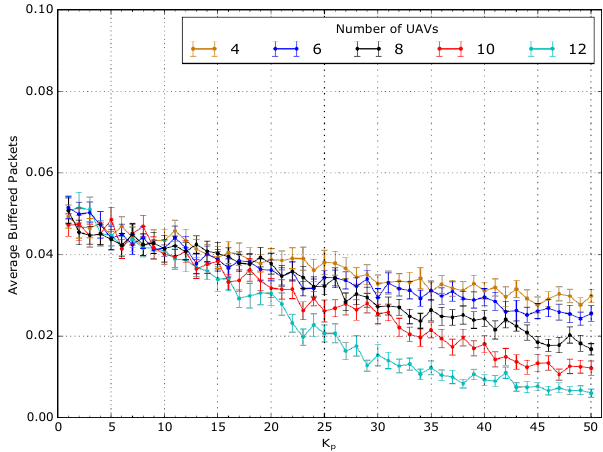
Figure 8. Average percentage of buffered packets in a scenario with 3 teams of 20